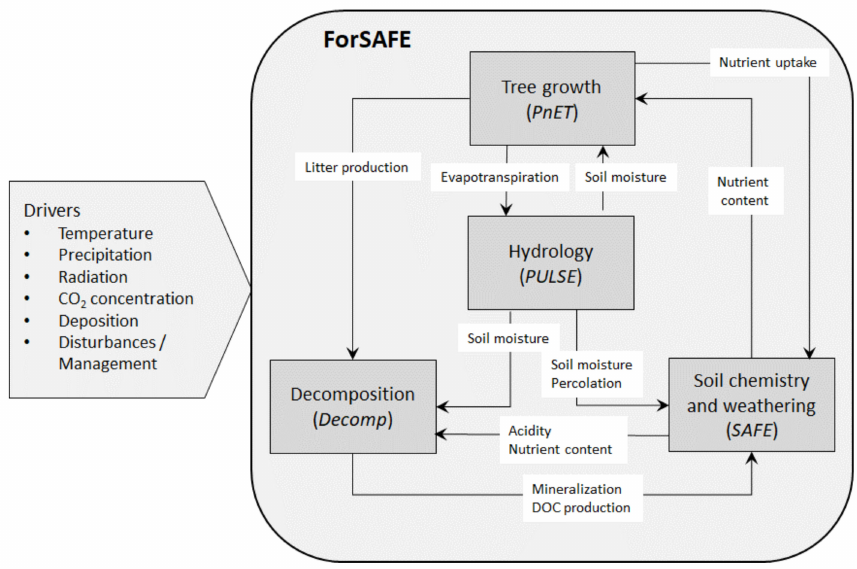
Figure 2. Illustration of different model components included in the ForSAFE model and their interactions. The names of the original models combined in ForSAFE are reported in brackets. The factors driving model processes are listed on the left of the figure.